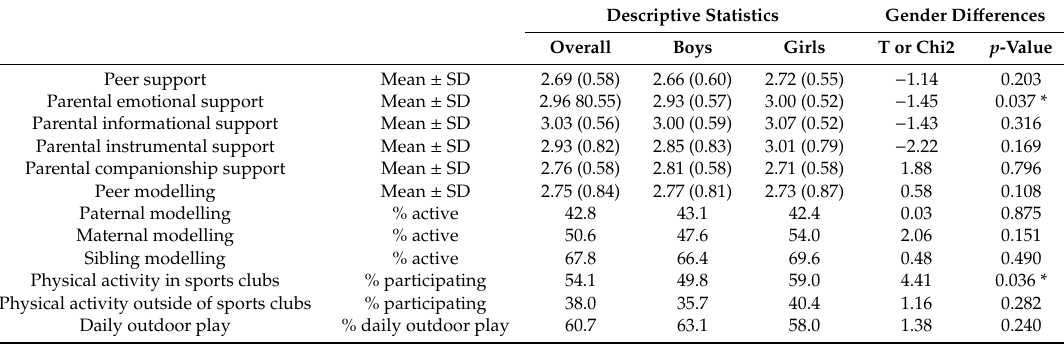
Table 2. Prevalence of social support, social modelling, and physical activity participation in di ff erent